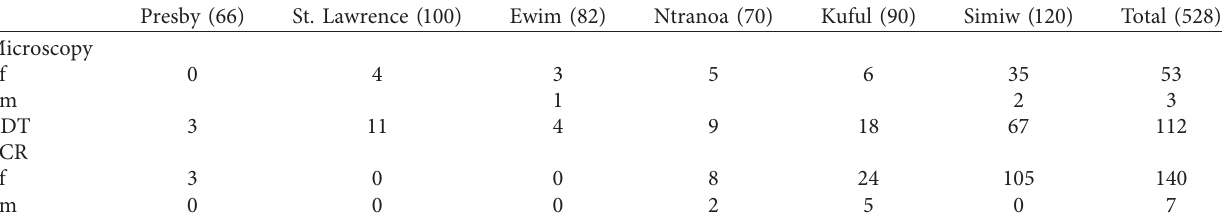
Table 2: Parasite prevalence.